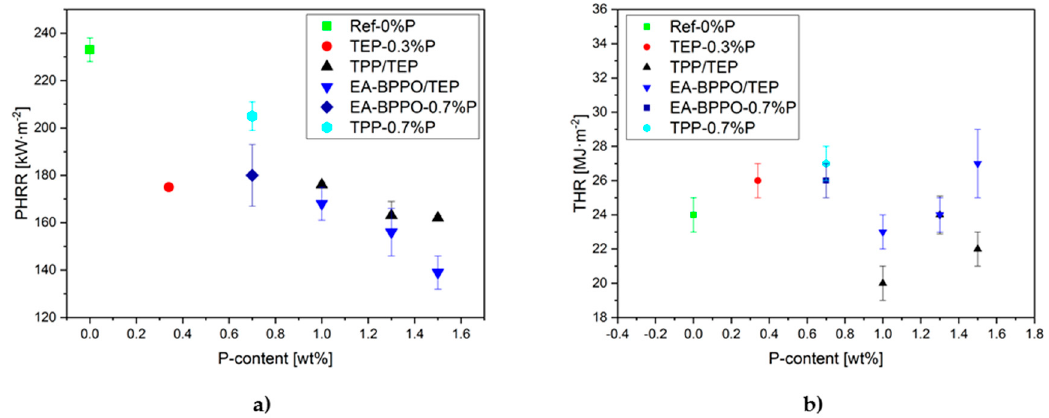
Figure 8. Correlation of ( a ) peak heat release rate (PHRR) and ( b ) total heat released (THR) of selected foams to their P-content.